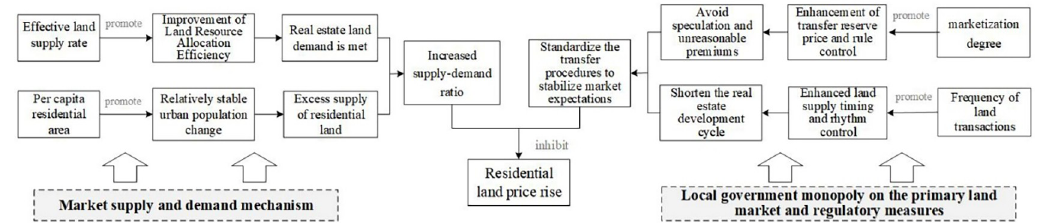
Fig 7. The mechanism of the inhibitory factors of residential land price